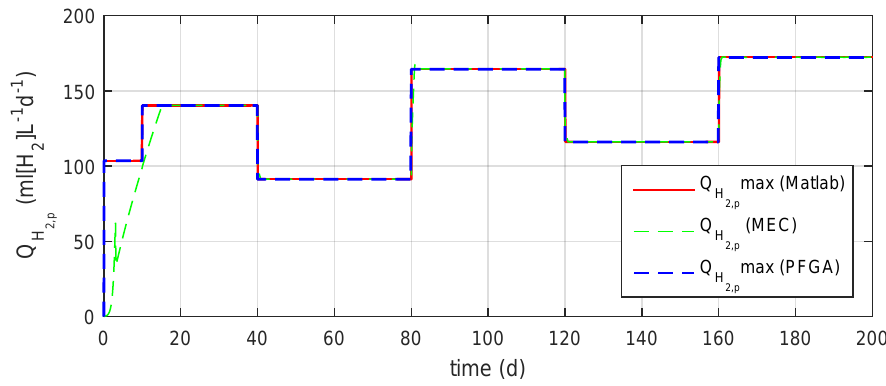
Figure 15. Q H results in Matlab and FPGA. 2, p max On the other hand, the dilution rate computed by the optimization algorithm both in the FPGA and in Matlab is shown in Figure 16. The green dashed-line represents the optimum dilution rate computed by the GSS algorithm, the red line represents the dilution rate computed by the DTSTC in Matlab, while the blue dashed-line represents the dilution rate computed by the DTSTC in the FPGA. As it can be seen, the numerical representation format used to design the optimizer’s digital architecture reduces properly the truncation error due to the finite number of bits.